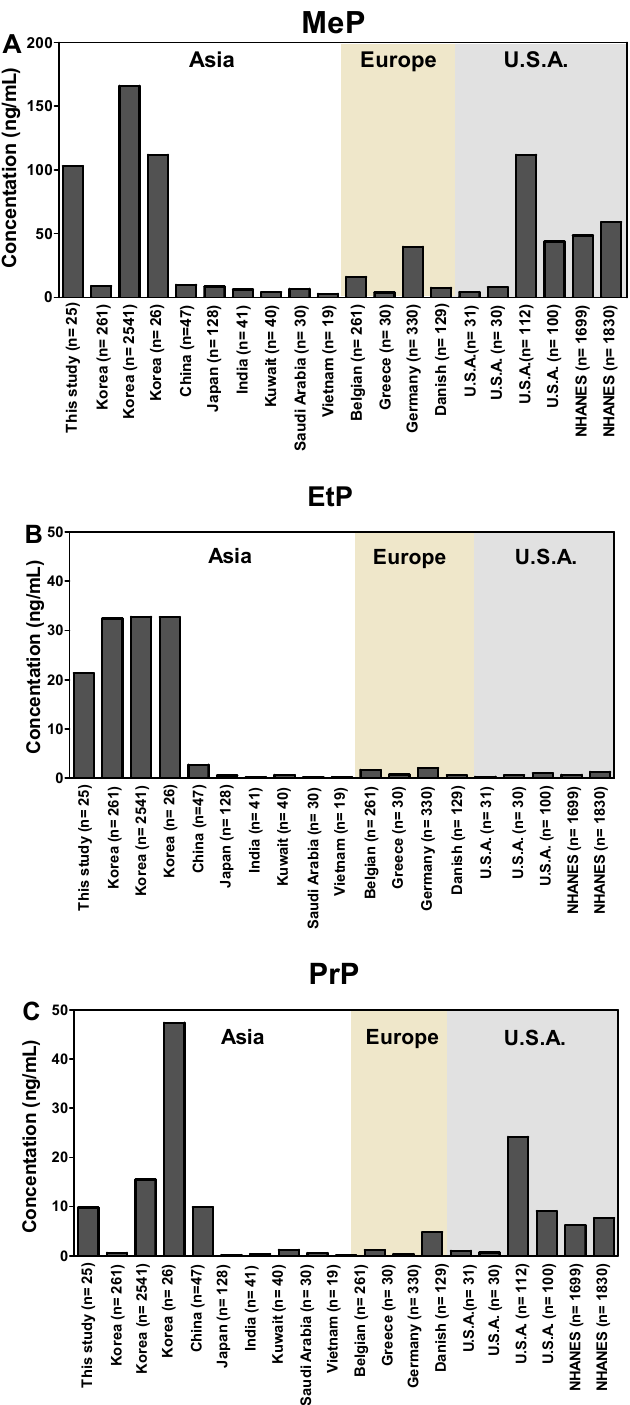
Figure 1. Urinary concentrations of ( A ) methyl paraben (MeP), ( B ) ethyl paraben (EtP), and ( C ) propyl paraben (PrP) in Korea, compared with those reported from other countries. NHANES stands for National Health and Nutrition Examination Survey of U.S.A.